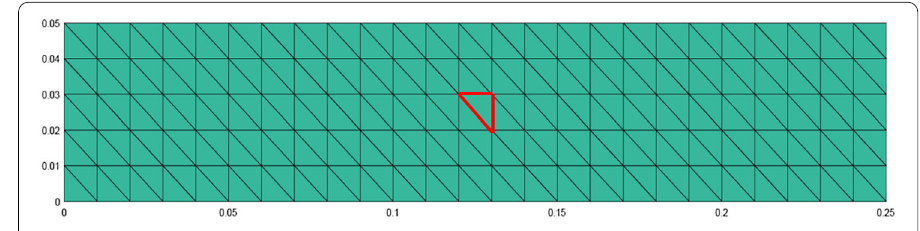
Fig. 2 Plate domain (cid:2) and its associated mesh